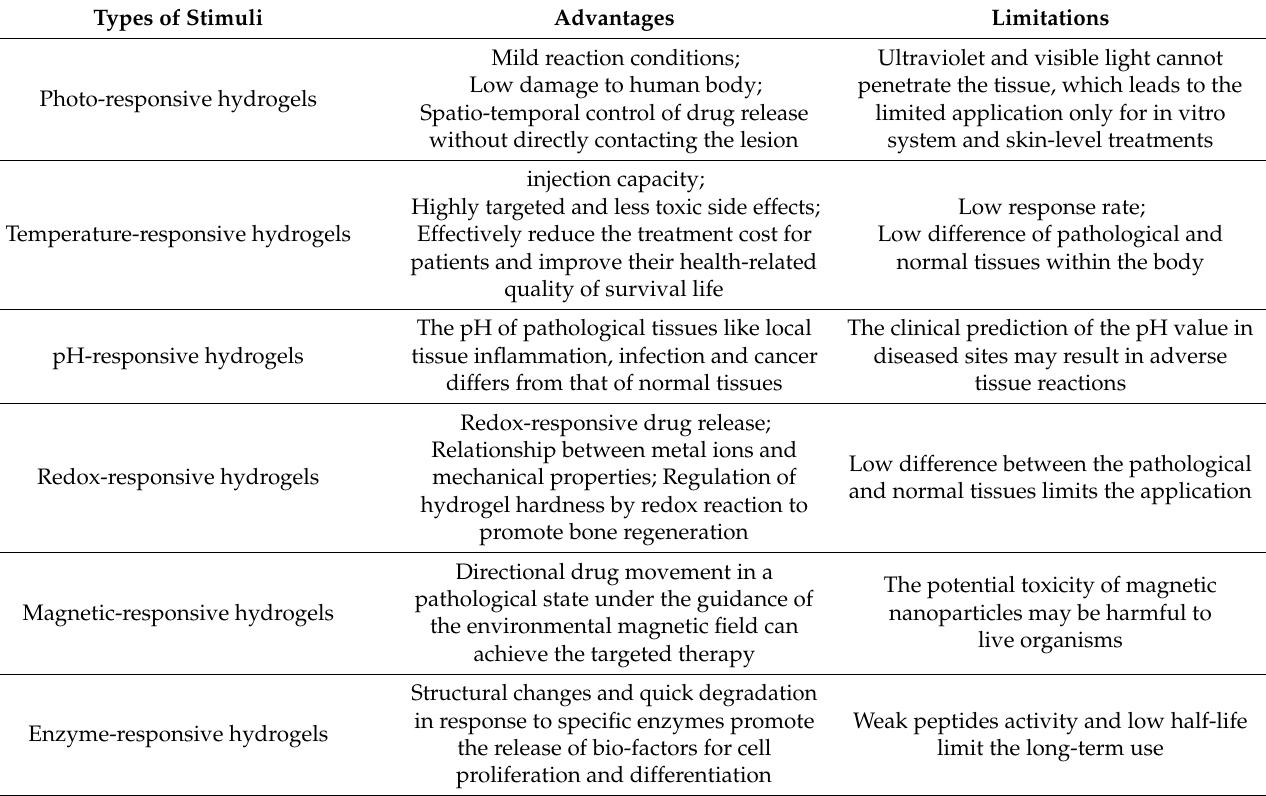
Table 1. The advantages and limitations of stimulus-responsive hydrogel